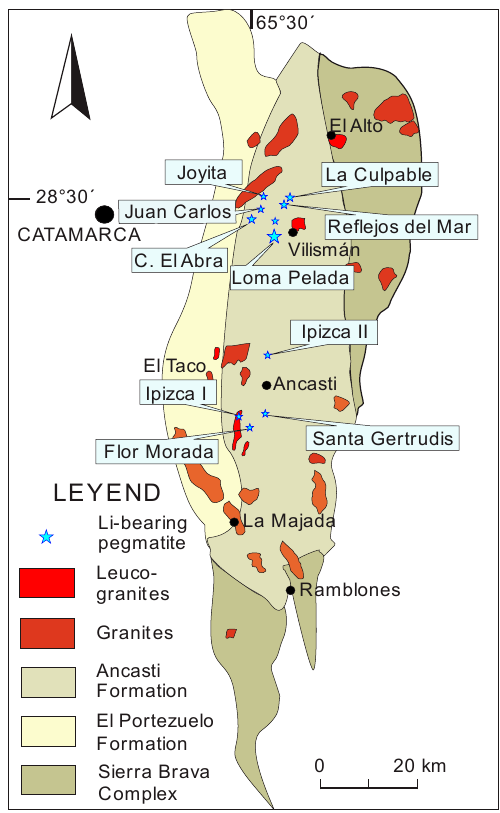
Figure 3. Geological map of the Ancasti district showing the distribution of the main Li-bearing pegmatite units.